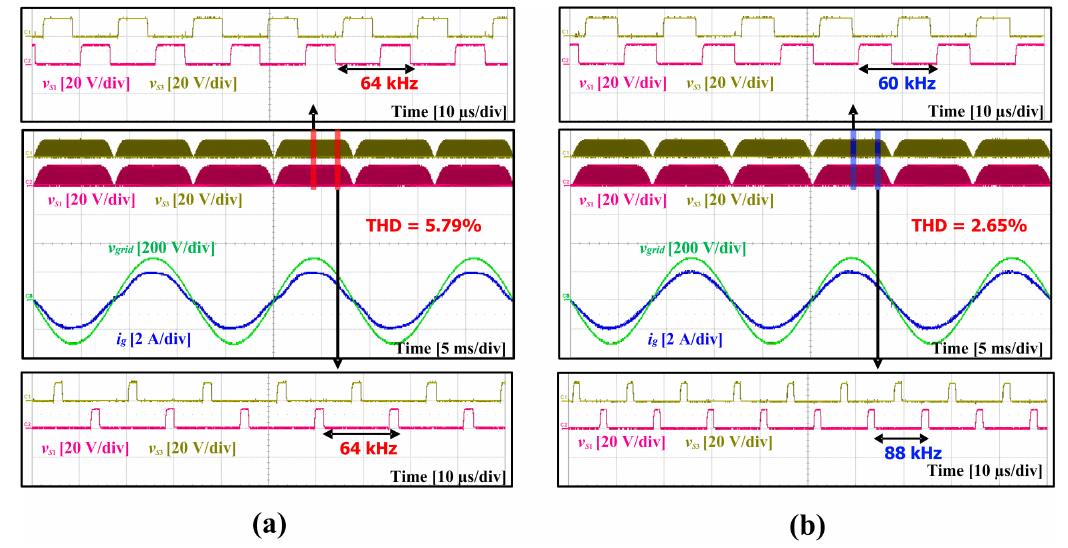
Figure 14. Gate signals of S 1 and S 3 , grid voltage and grid current in ( a ) the fixed and ( b ) the variable switching frequency controls.